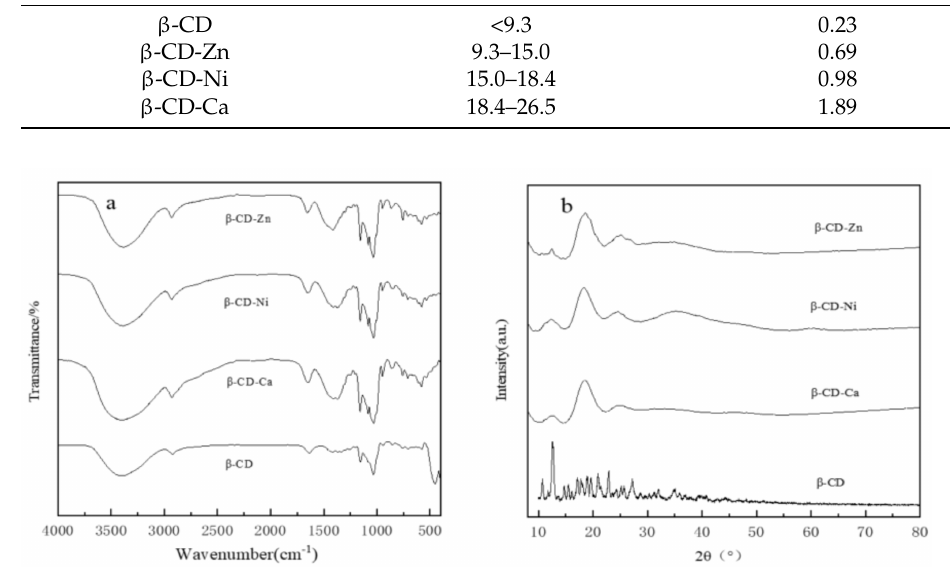
Figure 1. FT-IR spectra ( a ) and XRD patterns ( b ) of β -CD-Zn, β -CD-Ni, β -CD-Ca and β